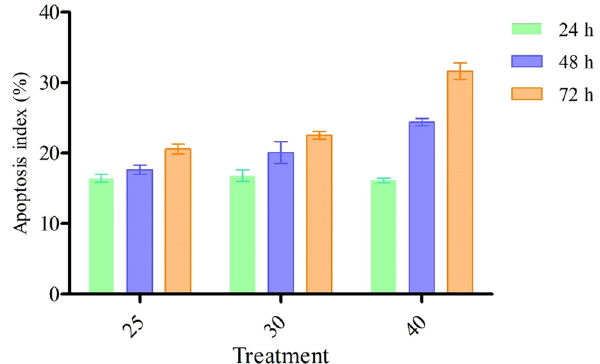
Figure 4: PI - staining induced apoptosis on LNCaP cells. LNCaP cells were treated with di ff erent concentrations of Equisetum arvense extract for 24, 48, and 72